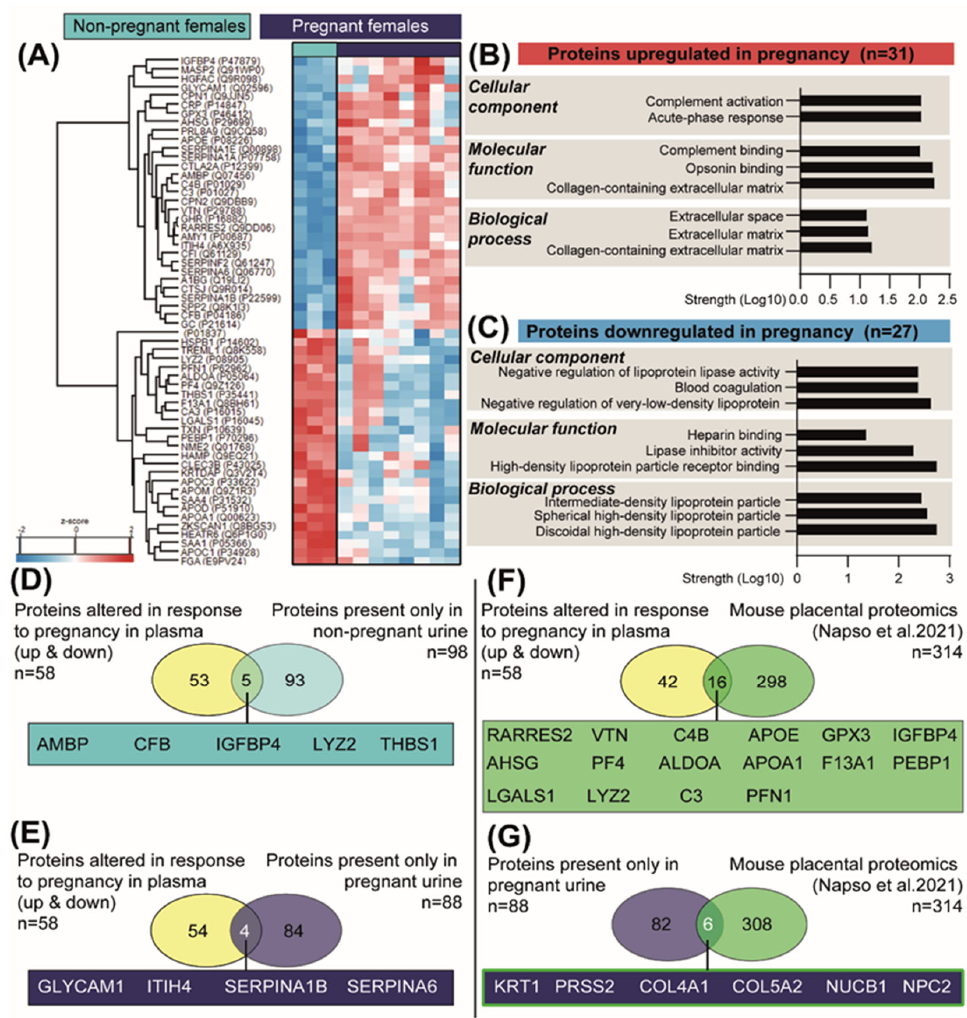
Figure 6. Changes in the abundance of plasma proteins in response to pregnancy in mice. ( A ) Heat map of differentially expressed plasma proteins between the pregnant and non ‐ pregnant mice, as detected by mass spectrometry (n = 3 non ‐ pregnant and n = 8 pregnant). ( B , C ) Top ‐ scoring cellular, molecular and biological processes for the 31 and 27 proteins upregulated and downregulated in pregnant mice, respectively. Analysis performed with STRING. ( D ) Venn diagram showing the overlay of proteins altered in plasma in response to pregnancy (upregulated and downregulated) with the proteins exclusively detected in the non ‐ pregnant urine. ( E ) Venn diagram showing the overlay of altered proteins in plasma in response to pregnancy (upregulated and downregulated) with the proteins exclusively detected in the pregnant urine. ( F ) Venn diagram showing the overlay of altered proteins in plasma in response to pregnancy (upregulated and downregulated) with proteins previously reported to be secreted by the mouse placenta [41]. ( G ) Venn diagram showing the overlay of proteins detected in the pregnant urine with proteins previously reported to be secreted by the mouse placenta [41].